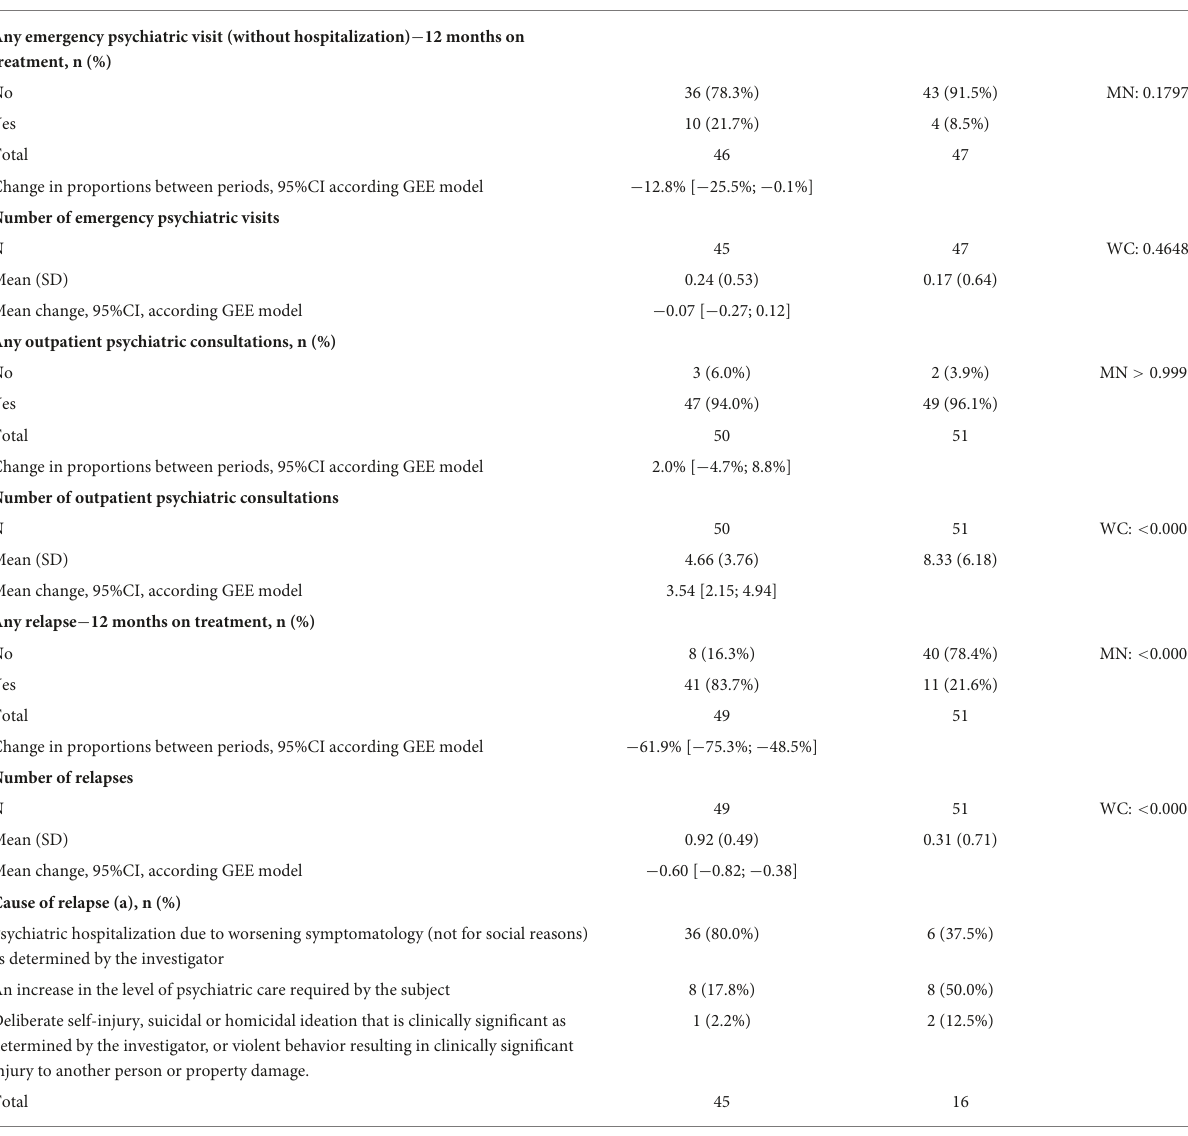
Treatment with OAP Treatment with PP1M P